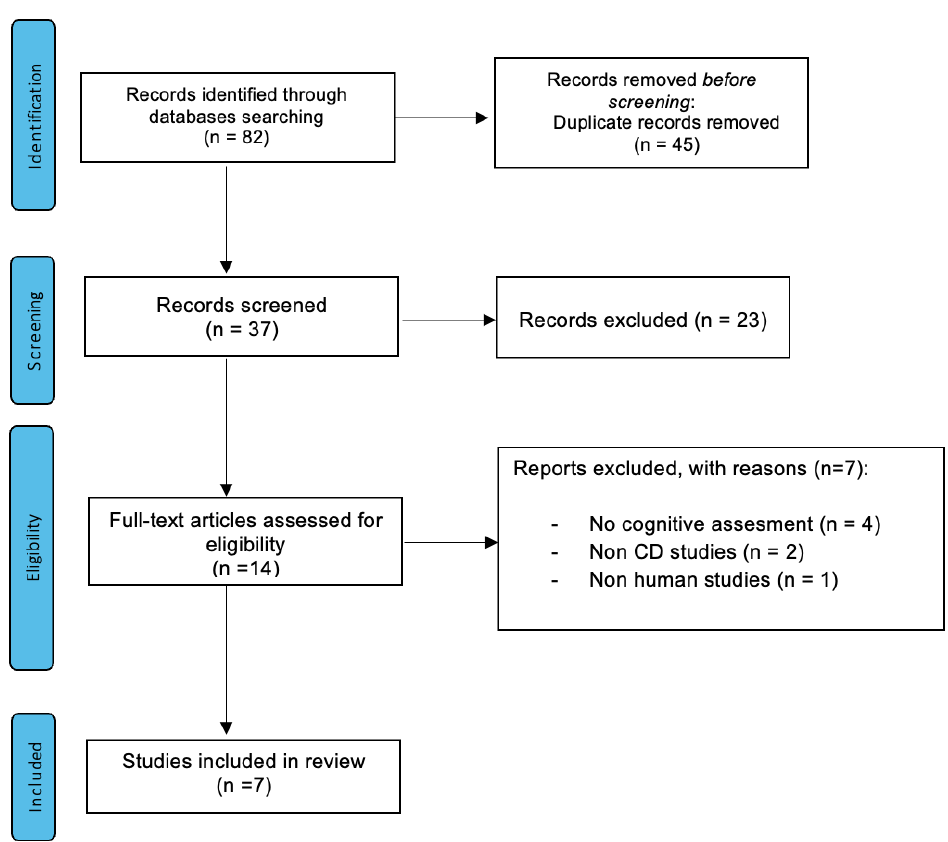
Figure 1. PRISMA flowchart of selection process for the scoping review of celiac disease-associated cognitive impairment articles/studies until May 2021.